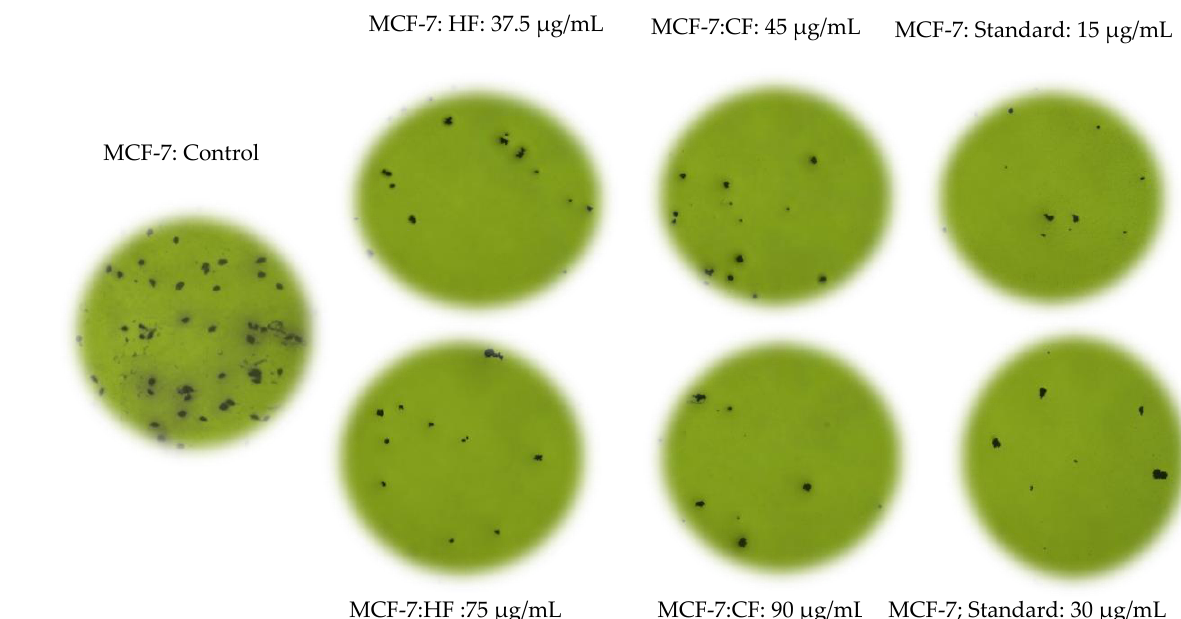
Figure 3. The MCF-7 cells’ colony formation ability following treatment with the hexane and chloroform fractions at two different concentrations from the standard cycloheximide. HF: hexane fraction; CF: chloroform fraction. Table 5. Plating efficiency and the surviving fraction of RMS and MCF-7 cells after being treated with hexane and chloroform fractions of C. minima , compared to the standard cycloheximide. Plating Sample (μg/mL) Efficiency